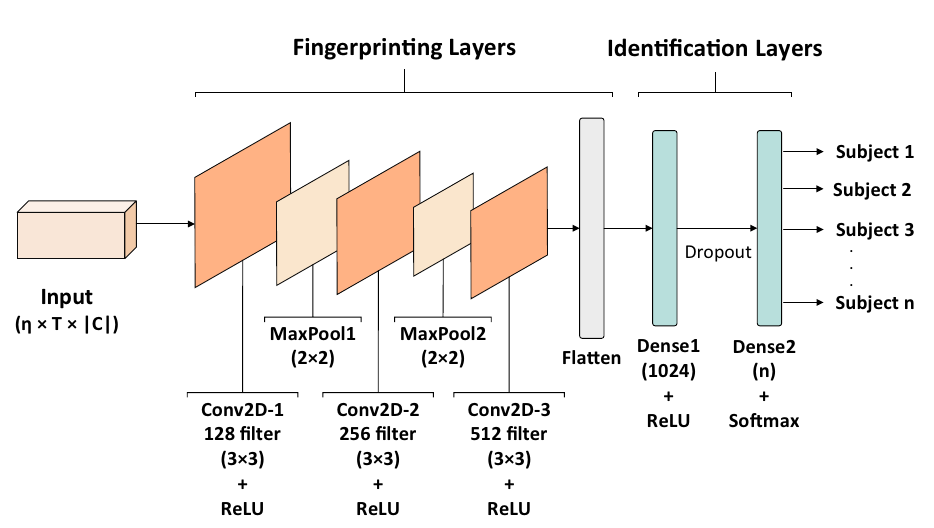
Figure 1. Overall schema of the proposed EEG authentication method.